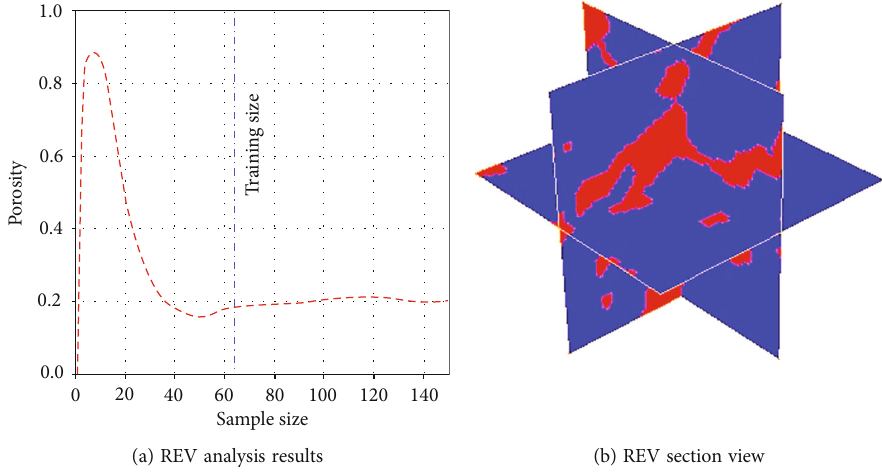
Figure 2: Representative volume element analysis and schematic diagram of Berea